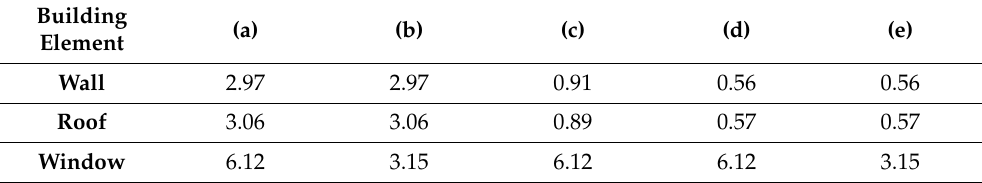
Table 7. U-Values in Wm − 2 K − 1 for each building fabric configuration used in dynamic simulations. The letters at the top of the table correspond to the sections shown in Figure